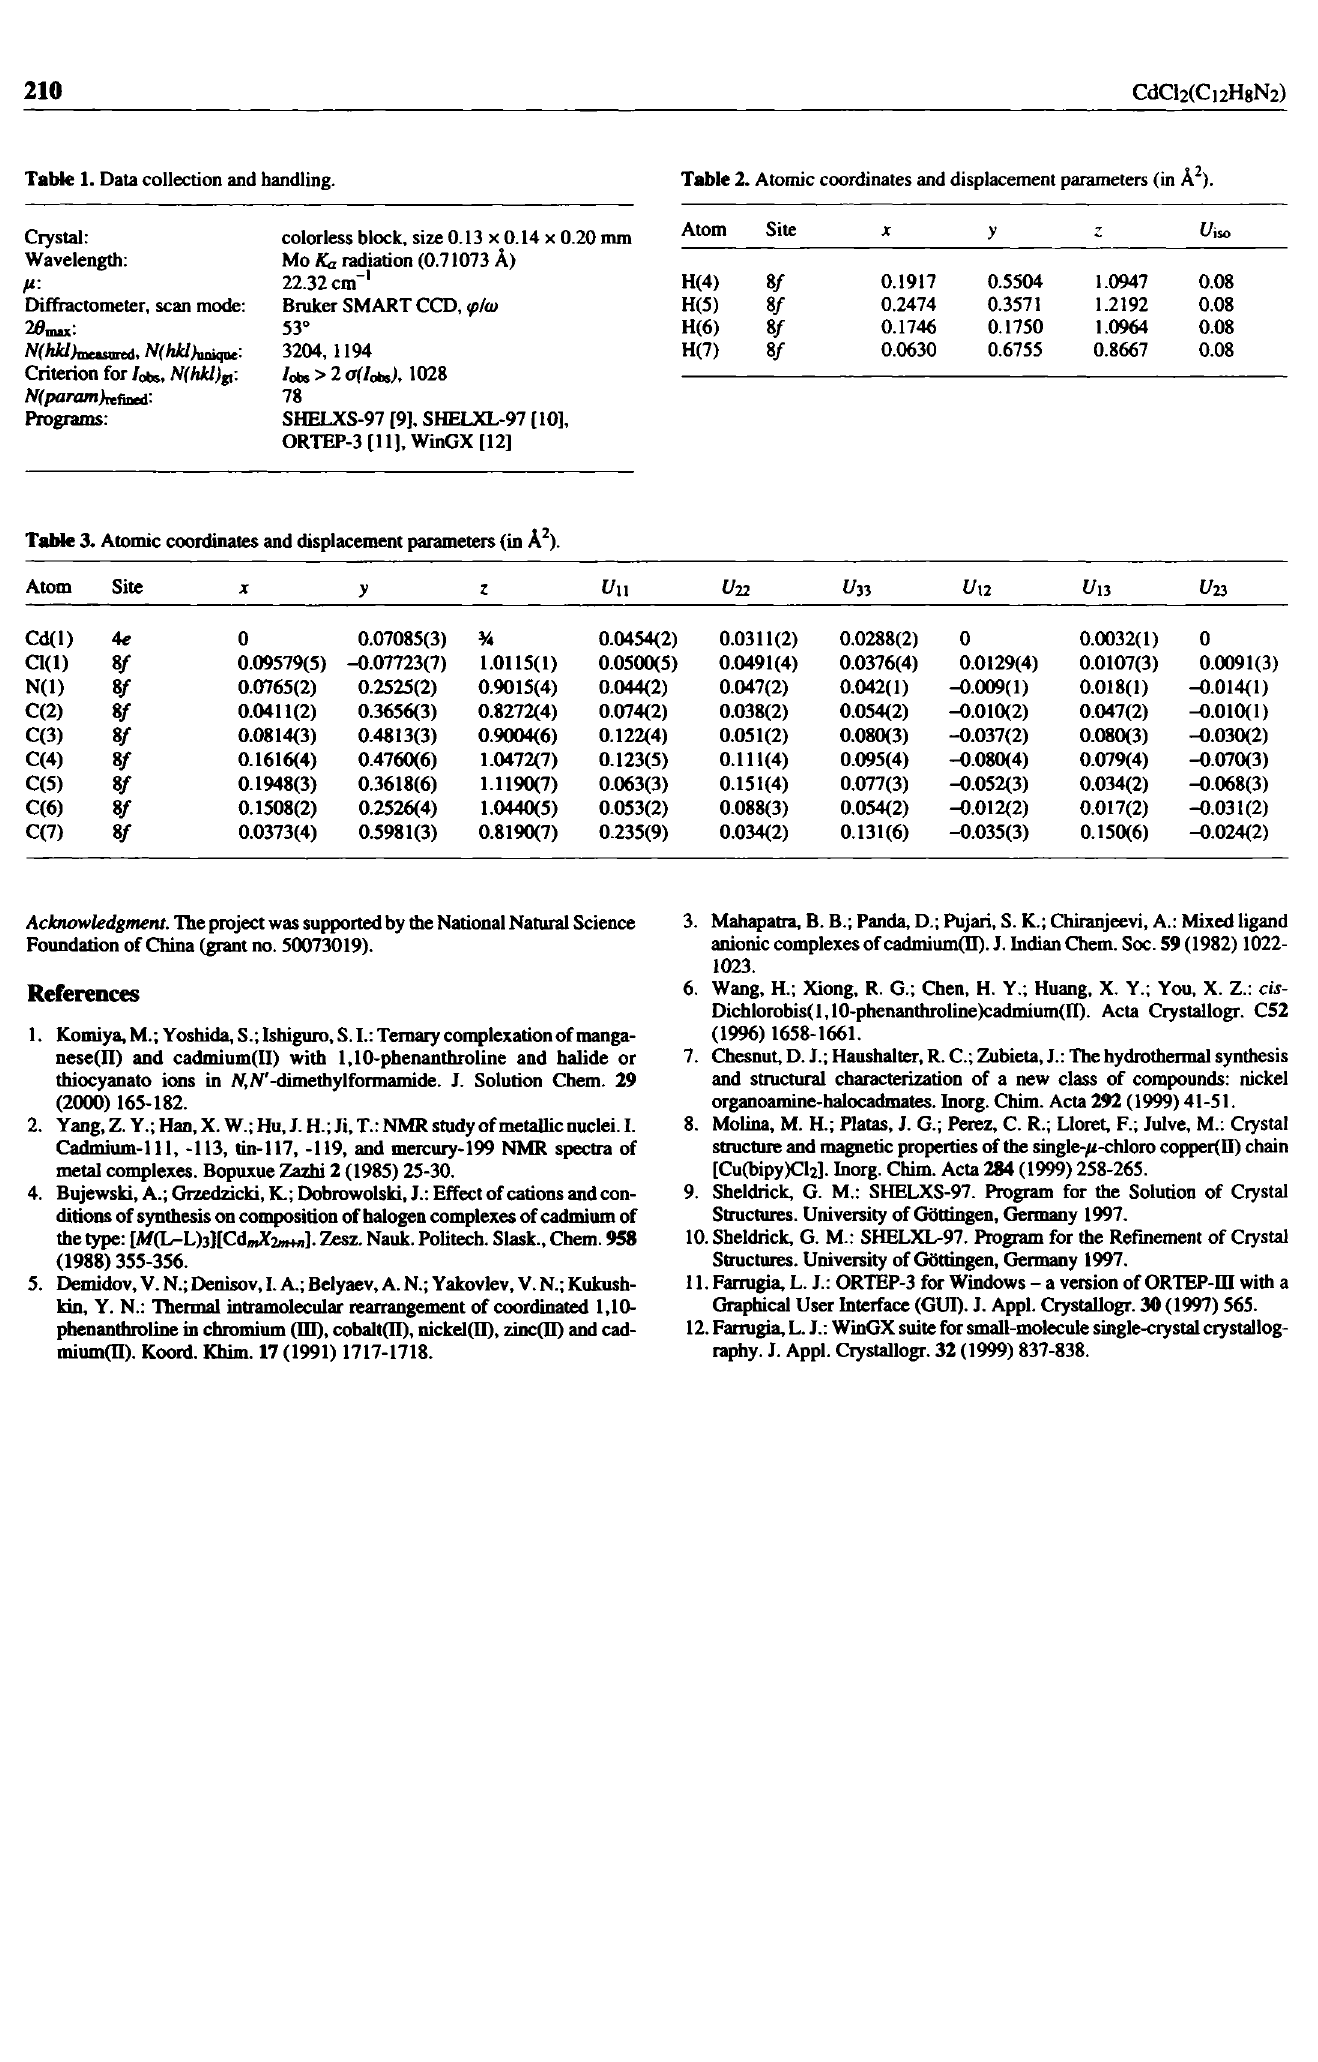
Table 1. Data collection and handling. Table 2. Atomic coordinates and displacement parameters (in Ä 2 ).